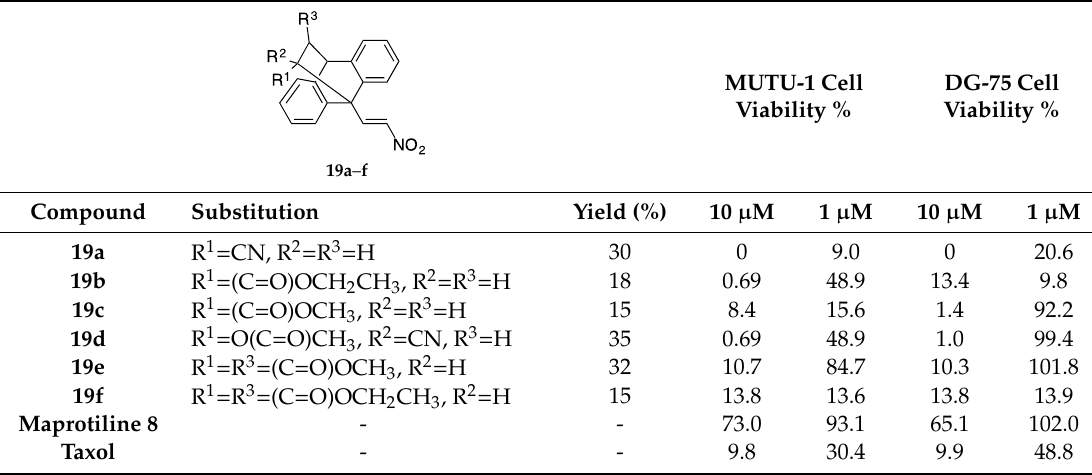
Table 6. Yields and preliminary cell viability data for compounds 19a – f (Series IV) in MUTU-1 and DG-75 Burkitt lymphoma cell lines a .